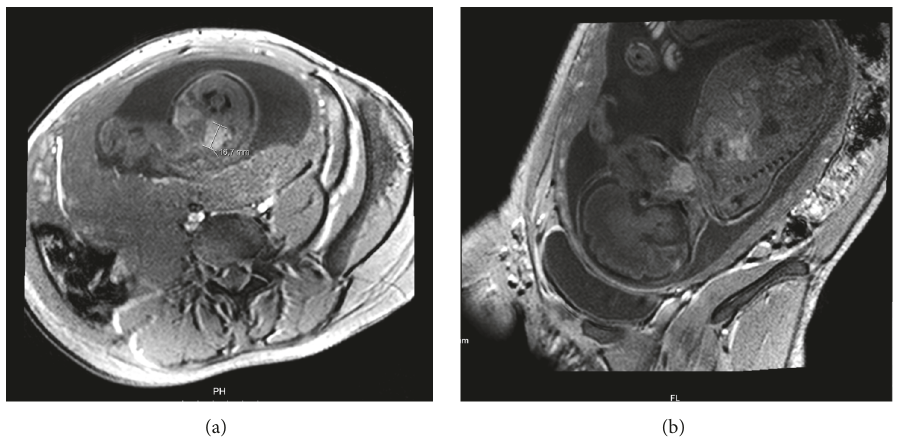
Figure 2: Fetal MRI showing fetal thyroid diffuse enlargement (a: coronal view; b: sagittal